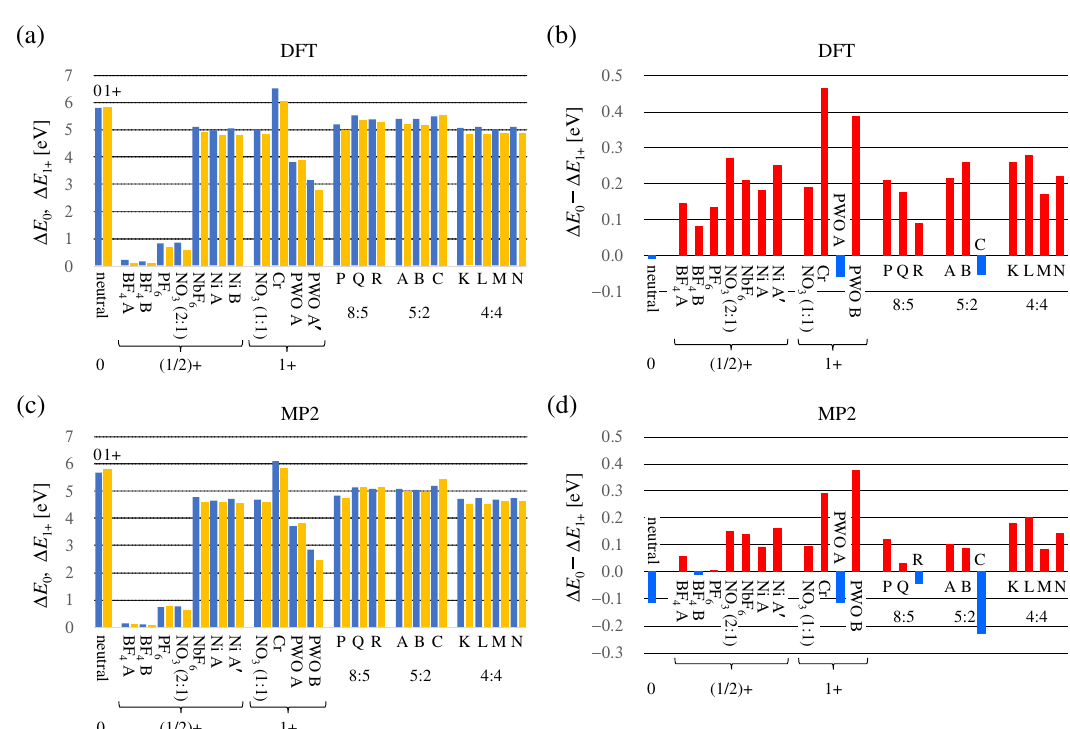
Figure 12. Visualization of ( a ) ∆ E 0 and ∆ E 1 + ; and ( b ) ∆ E 0 − ∆ E 1 + obtained by the DFT calculations in Table 3. ( c , d ) The correspondents by the HF energy calculations and its correlation-energy correction by the MP2 calculations in Table